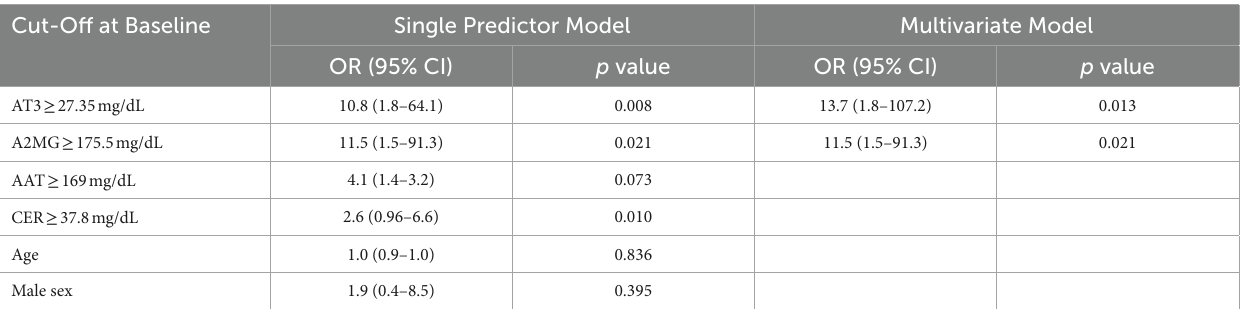
TABLE 3 Cut-Off levels for APPs at baseline derived by ROC analysis used in single predictor and multivariate logistic models adapted from (28). Cut-Off at